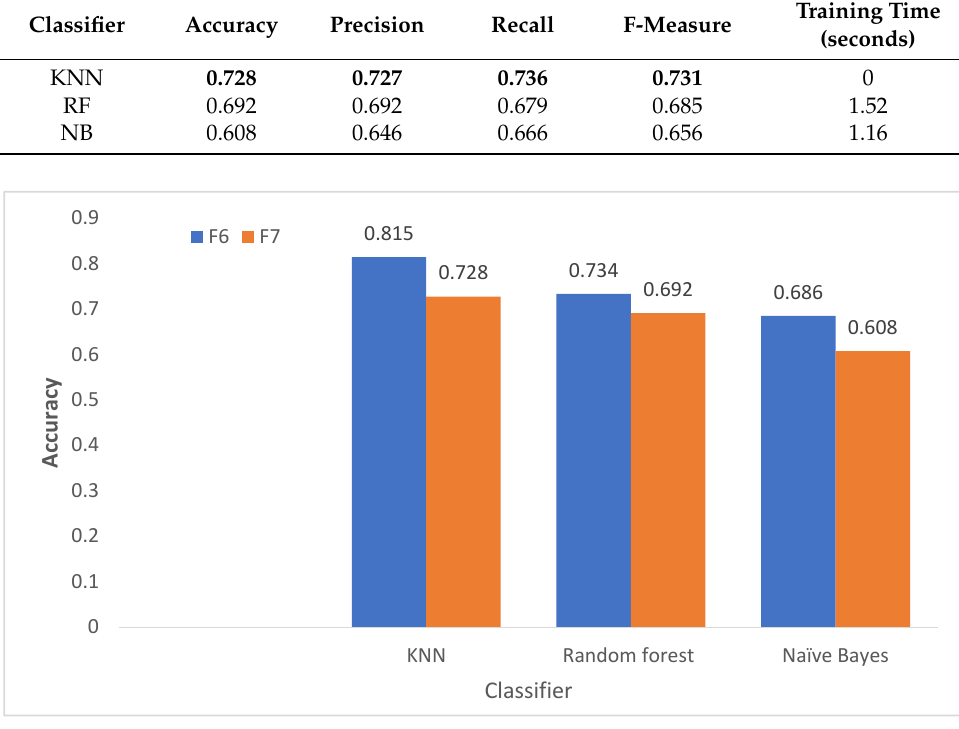
Table 5. Identification results of VGG-19-F6 deep features with PCA (95%, 97%, and 99%). Bold values signify the best performance. Classifier